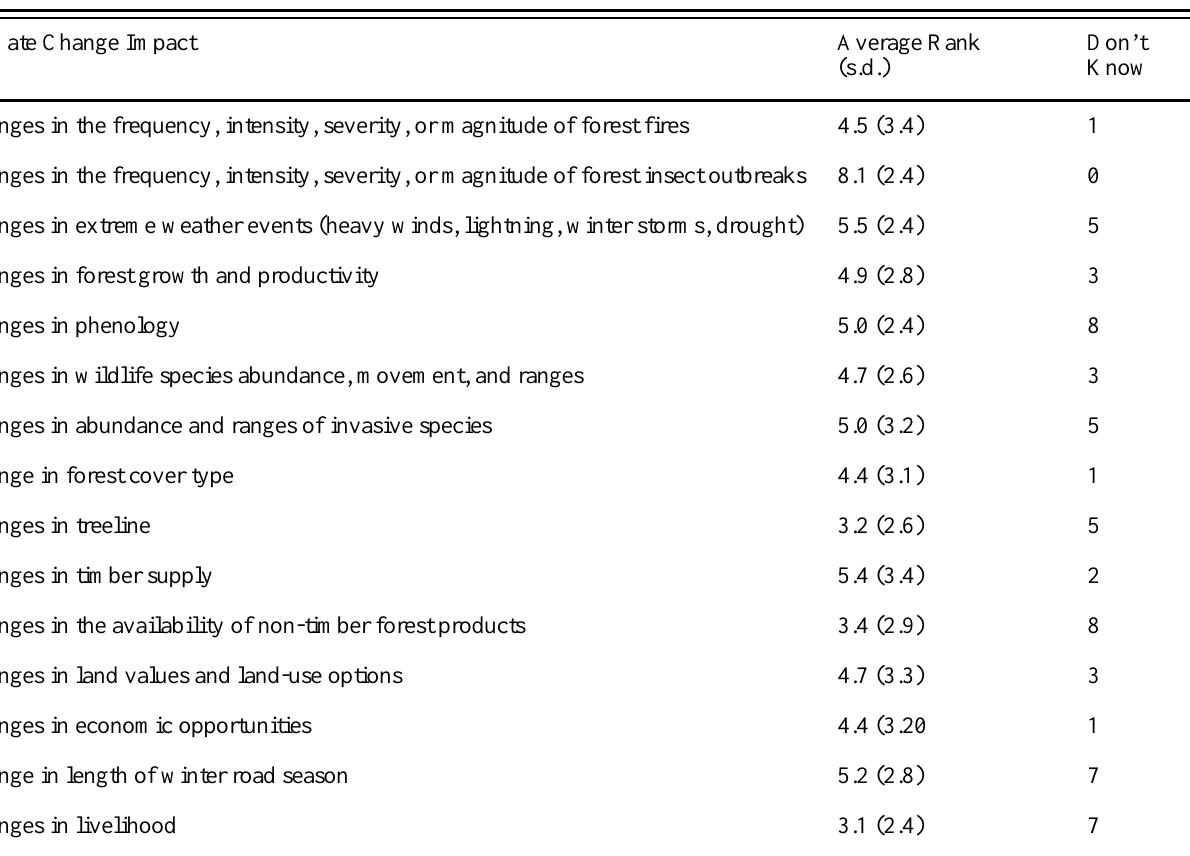
Table 1. Judgments of forest practitioners on the degree of change in various attributes of environmental, social, and economic systems observed over the past 20 years in the Champagne and Aishihik Traditional Territory in response to recent climate warming. Scale of 1 to 10 (0 = no change, 1 = low, 10 =high) or don’t know. Results shown are the average rank and standard deviation (s.d.) of participants who provided a ranking and number of participants who indicated that they don’t